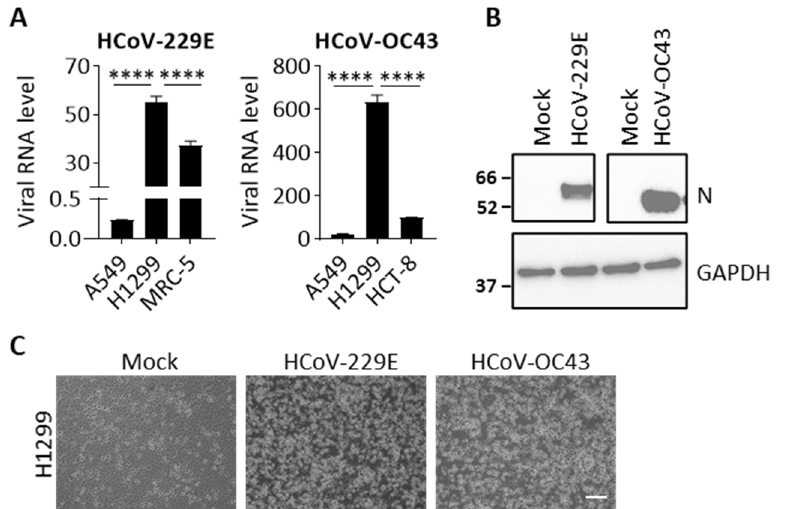
Figure 1. HCoV-229E and HCoV-OC43 infection in human cells. ( A ) Cell lines, including A549, H1299, MRC-5, and HCT-8 were infected with HCoV-229E (MOI 0.05) or HCoV-OC43 (MOI 0.01). Viral RNA in cell lysates was quantified by real-time PCR at 24 hpi. Data show viral RNA levels relative to GAPDH. Error bars represent SD ( n = 3). Statistical analysis was conducted with one-way ANOVA: ****, p < 0.0001. ( B ) Representative western blot images showing the expression viral N protein and GAPDH (loading control) in cell lysates at 24 hpi. Full size images are presented in Supplementary Figure S1. ( C ) Representative images show CPEs in the HCoV-229E or HCoV-OC43- infected H1299 cells at 48 hpi. Scale bar, 10 μ m.